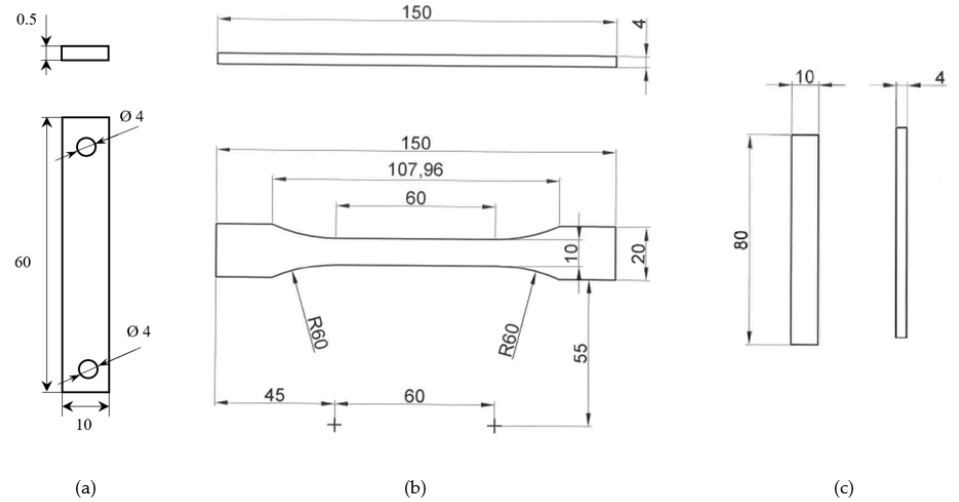
Figure 1. Dimensions in millimeters of the tensile test specimens: ( a ) single-ply tensile specimen, ( b ) multi-ply tensile specimen, ( c ) multi-ply bending specimen. ( b ) multi-ply tensile specimen, ( c ) multi-ply bending